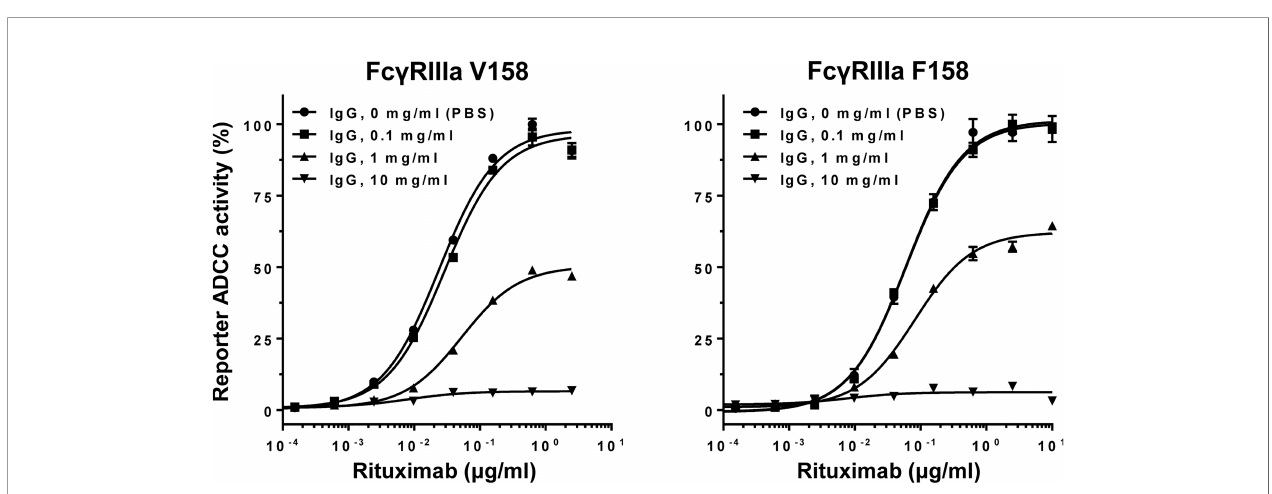
FIGURE 3 | Normal polyclonal IgG inhibits ADCC in a dose-dependent manner. Note that activation of Fc g RIIIa V158 or F158 variant was inhibited by normal IgG at >0.1 mg/ml. Error bars, mean ± S.E. (n =